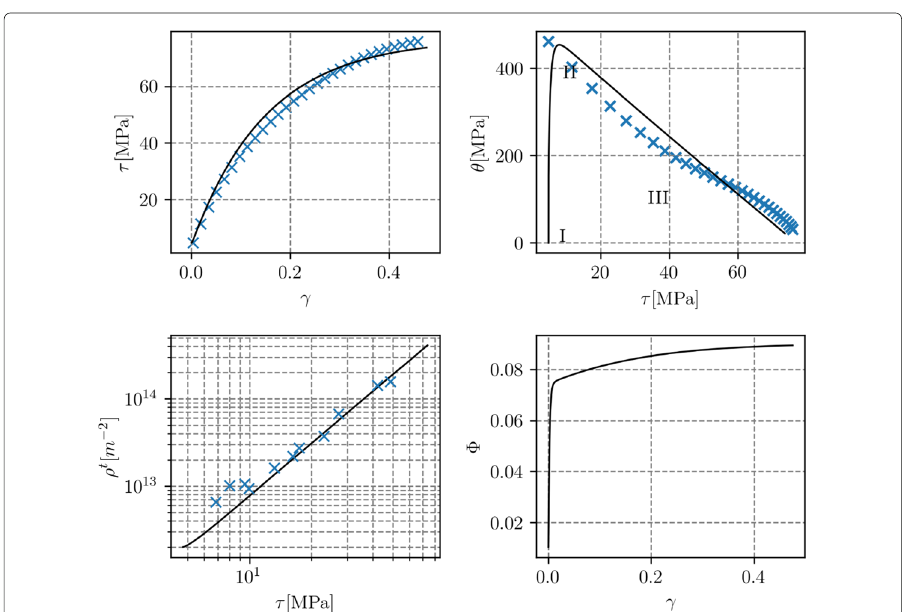
Fig. 8 First 3 stages of work hardening in cooper rolling. Experimental measures marked by [ × ] obtained from Göttler (1973). Top-left: resolved shear stress(RSS) against plastic slip. Top-right: hardening-rate vs RSS; Hardening rate of experimental measures are obtained by fitting a 6th-order polynomial to stress-strain curve. Bottom-left: log-log plot of dislocation density vs RSS; This plot shows that dislocation density eventually saturates as the RSS can not increase any more. Bottom-right: Dislocation-entanglement (cid:15) (cid:16) (cid:19) = q /ρ 1.5 vs plastic slip